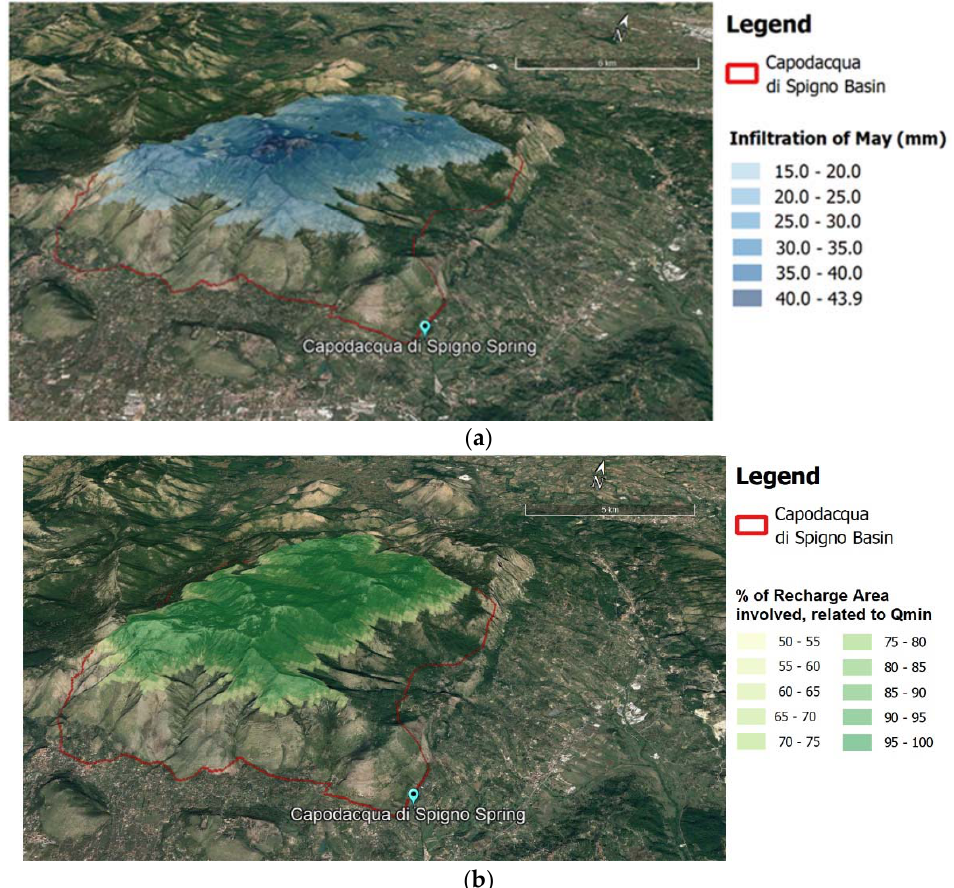
Figure 17 . ( a ) Infiltration distribution of May (month of infiltration related to the minimum spring flow rate), by using the inverse hydrogeological balance [23]; ( b ) % of recharge area involved related to Qmin (2018), by using the isotope driven model [21].